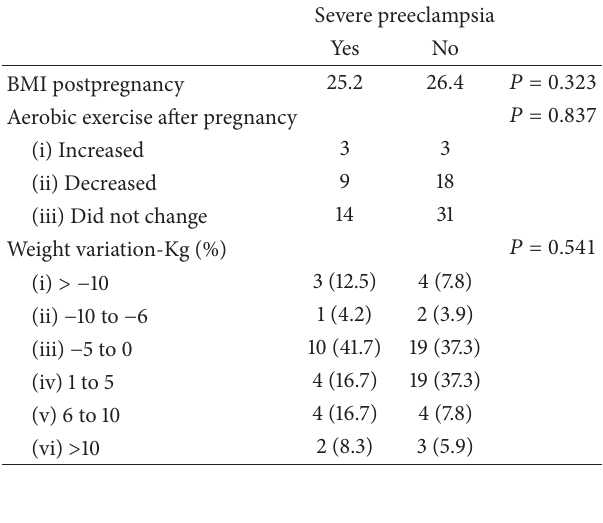
Table 3: Association between preeclampsia severity and lifestyle modifications.